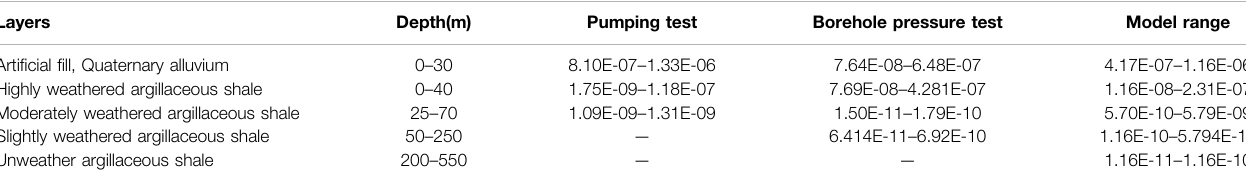
TABLE 1 | Hydraulic conductivity of layers calculated from previous tests (unit: m/s).